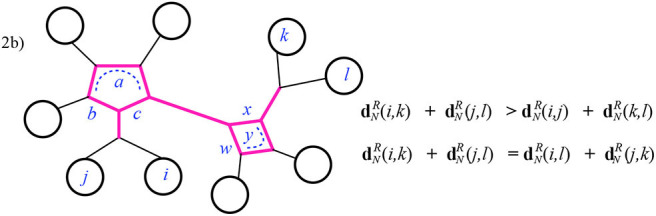
Case 2 of Theorem 3.1 continued. Here vi = vj and vk = vl.